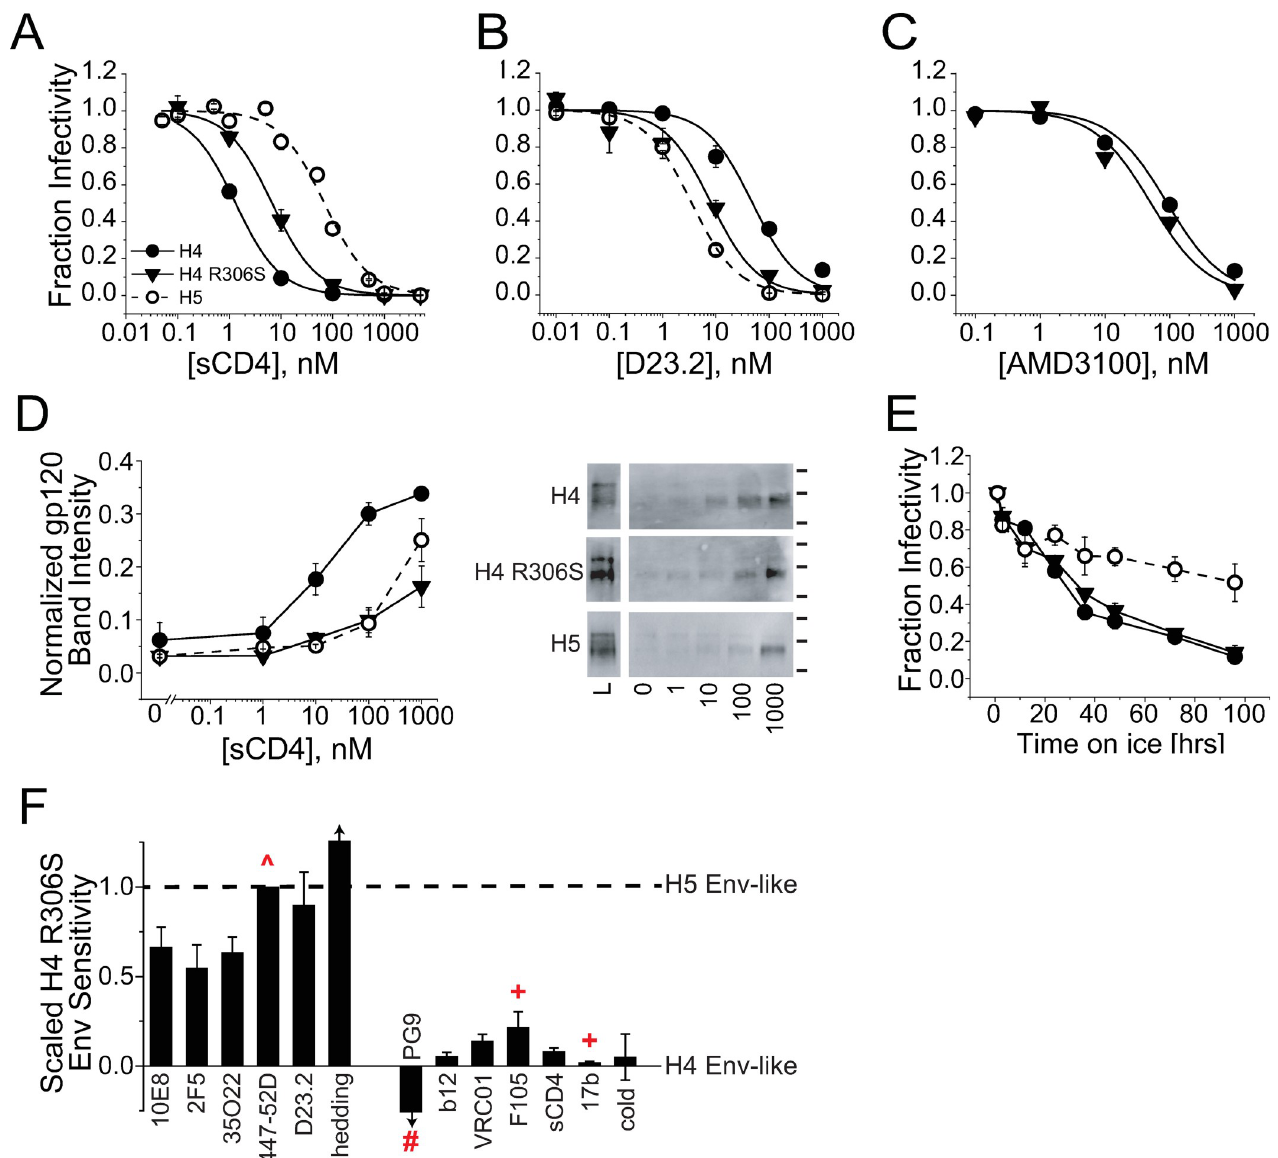
Fig 7. The R306S substitution in H4 Env conferred some of the functional and energetic properties of H5 Env while maintaining others from the H4 Env background. ( A-C ) Inhibitory titrations of sCD4 ( A ), CD4 antagonist D23.2 ( B ) and CoRA AMD3100 ( C ) against HIV-1 pseudotyped with H4 Env (filled circles), H5 Env (open circles) and H4 R306S Env (triangles). Of these three inhibitors, only D23.2 showed significantly different potencies when comparing H4 R306S to H4 Env (one-way ANOVA with means comparison using the Tukey method, p < 0.025). ( D ) Soluble CD4 dependence to gp120 shedding from H4, H4 R306S and H5 Env-expressing cells. Shed gp120 was detected by SDS-PAGE/Western blot, quantified by densitometry and normalized to the total gp120 detected in cell lysates. In the images of representative Western blots (right), L denotes a 1:3 dilution of cell lysate; the lines to the right of the images indicate positions of 250, 150 and 100 kDa molecular weight markers. The H4 R306S Env data set is significantly different from the H4 Env data set (two-way ANOVA, p < 0.01) but not statistically different from the H5 Env data set (p > 0.20). ( E ) Time dependence to cold inactivation of HIV-1 pseudotyped with H4, H4 R306S or H5 Env. The H4 R306S data set is significantly different from the H5 Env data set (two-way ANOVA, p < 0.01) but not statistically different from the H4 Env data set (p > 0.40). Data points in A-E represent the mean ± SEM of three or more independent experiments. ( F ) Sensitivity profile of H4 R306S Env scaled to the differences between H4 and H5 Env sensitivities. For each inhibitor, the IC50 value for H4 R306S Env was transformed according to the following formula: